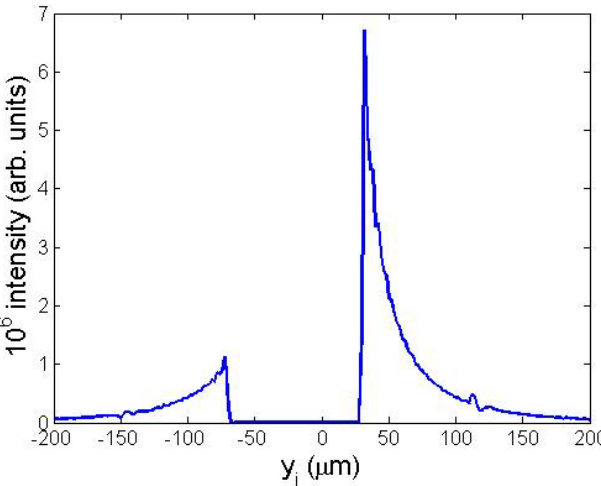
FIG. 8. (Color) 1D image formed with the ODR when a single electron passes through a rectangular slit with 20 (cid:8) m offset to (cid:3) 0 . the slit center. x i